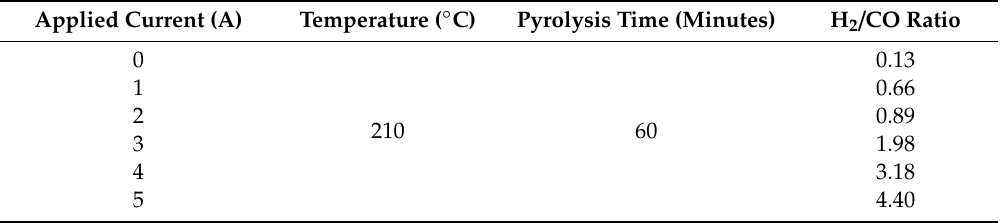
Table 2. The ratio of H 2 / CO in the pyrolysis system modified with electromagnetic